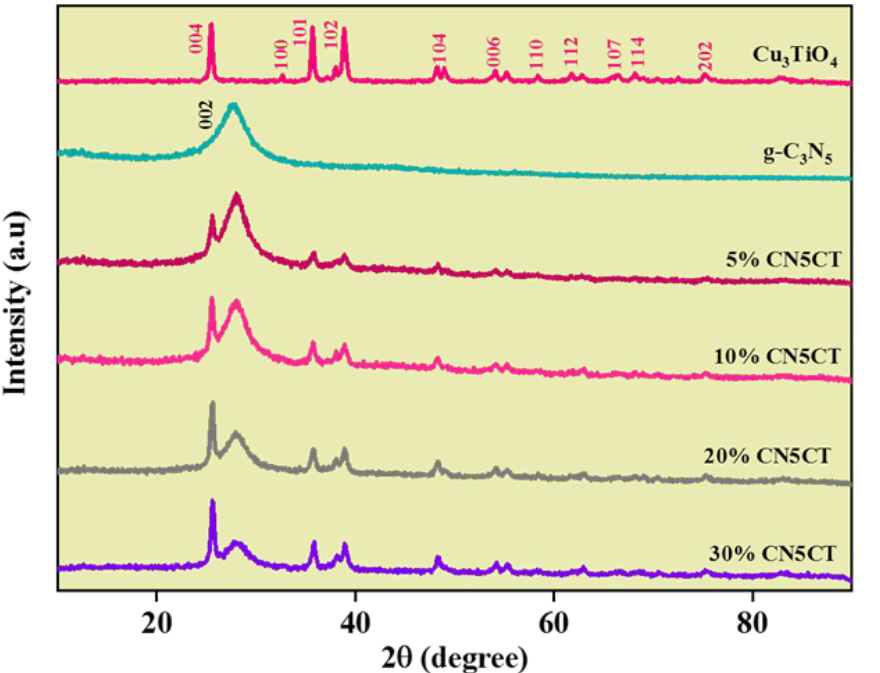
Figure 1. XRD images of prepared CN, CT and various percentages CNCT nanocomposites. In BET analysis the surface area of the designed nanocomposites was examined, and depicted in Figure 2a. The surface area of Cu 3 TiO 4 nanoparticles, g-C 3 N 5 and g-C 3 N 4 values are 10, 15, and 14 m 2 /g respectively. Then 10% CN5CT nanocomposite has 19 m 2 /g after supporting Cu 3 TiO 4 -nanoparticles, which thereby increased the surface area. The Cu 3 TiO 4 /g-C 3 N 4 has less surface area compared to 10% CN5CT, as shown in Figure 2a. From BET analysis, 10%CN5CT exhibited more surface and active sites compared to others. In FT-IR spectroscopy (Figure 2b), g-C 3 N 5 sheets showed peaks at 808, 1234, 1405, 1575, and 2160 cm − 1 , respectively. The signal at 808 cm − 1 corresponds to the existence of triazine units in g-C 3 N 5 nanosheets. NH 2 and NH peaks were obtained at 3500 cm − 1 and triazine unit stretching bands were found at 1200 cm − 1 . The g-C 3 N 5 nanosheet FT-IR report is consistent with previous literature. [67,68]. The FT-IR spectrum of Cu 3 TiO 4 exhibited a range between 400–700 cm − 1 bands, which is owing to Ti-O-Ti and Cu-O stretching vibration [69]. After that, Cu 3 TiO 4 nanoparticles supported the slight shift that happened in 5%, 10%, 20%, and 30% CN5CT nanocomposite.